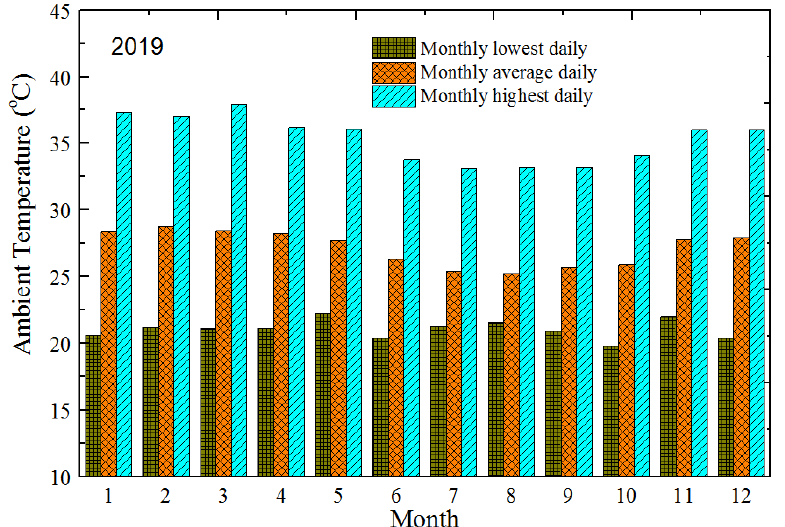
Figure 4. Monthly variation of ambient temperature in 2019 .